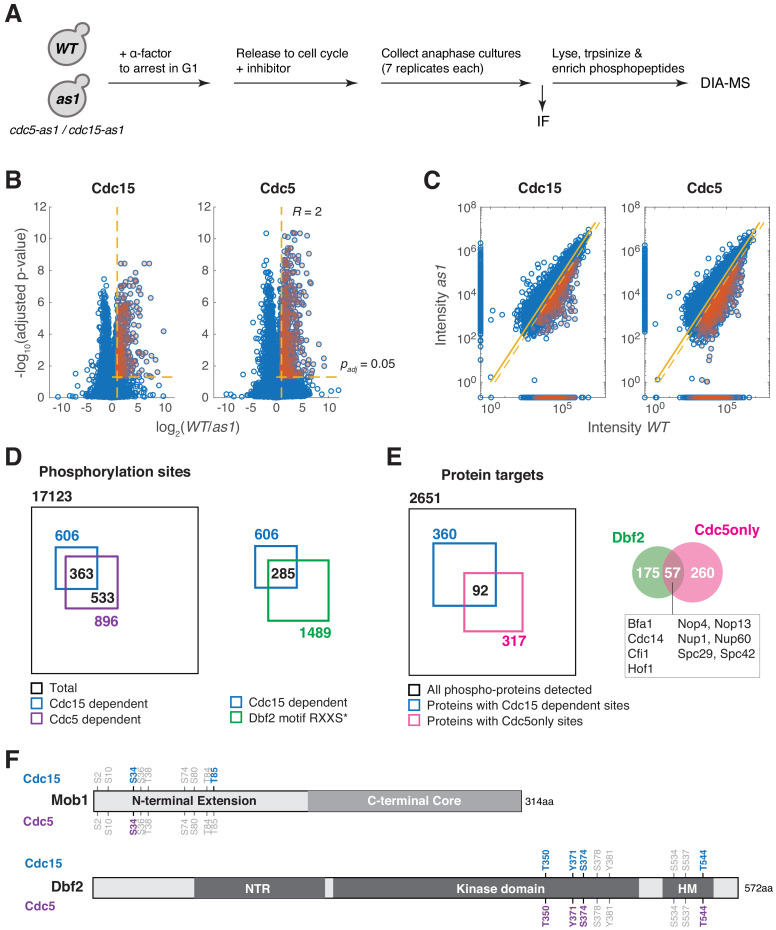
Phosphoproteomics identifies CDC15 (mitotic exit network [MEN]) and CDC5 dependent phosphorylation in anaphase.(A) Overview of the sample preparation for phosphoproteomics analysis to map CDC15 (MEN) and CDC5 dependent phosphorylation in anaphase. Paired wild-type (WT, A2587) and cdc15-as1 (A10991) or paired wild-type and cdc5-as1 (A40903) cultures were synchronized in G1 with α-factor (5 μg/ml). After 150 min cells were released into fresh medium with the corresponding inhibitors in the absence of pheromone at room temperature. After ~100 min cells were harvested to extract proteins and processed for data-independent acquisition mass spectrometry (DIA-MS) analysis with seven technical replicates for each sample. Immuno-fluorescence (IF) using an anti-tubulin antibody was performed on the collected cells to determine the percentage of cells with anaphase spindle (~70% for wild-type cells and ~95% for cdc5-as1 and cdc15-as1 cells). (B) Volcano plots of −log10 transformed FDR adjusted P-value versus log2(fold change or ratio) of intensities measured for peptides identified in anaphase cells with WT or analog-sensitive (as1) alleles of CDC15 or CDC5. Yellow dashed lines indicate the cutoff (R > 2 and padj<0.05) used to identify peptides whose phosphorylation depends on the corresponding kinase as marked with red shaded dots. (C) Correlations of peptide intensity in WT and as1 samples for Cdc15 and Cdc5 inhibition in anaphase. Data points on the axis represent peptides that were only detected in one sample but not the other. Red shaded dots denote hits for CDC15 or CDC5-dependent phosphopeptides identified based on the cutoff described in (B) and for peptides that were detected in at least five out of seven replicates in WT samples but were missing in as1 samples (thus no fold change could be calculated). (D and E) Summary of phosphorylation sites (D) and phospho-proteins (E) determined as CDC15- or CDC5-dependent. Potential Dbf2-Mob1 targets were identified as CDC15-dependent and to fit the Dbf2 phosphorylation consensus motif RXXS*, where * denotes the site of phosphorylation. Cdc5-only sites are sites that are CDC5-dependent but not CDC15-dependent. (F) CDC15- and CDC5-dependent sites in Mob1 and Dbf2. Light gray sites represent sites that were detected but were not determined as either CDC15- or CDC5-dependent.